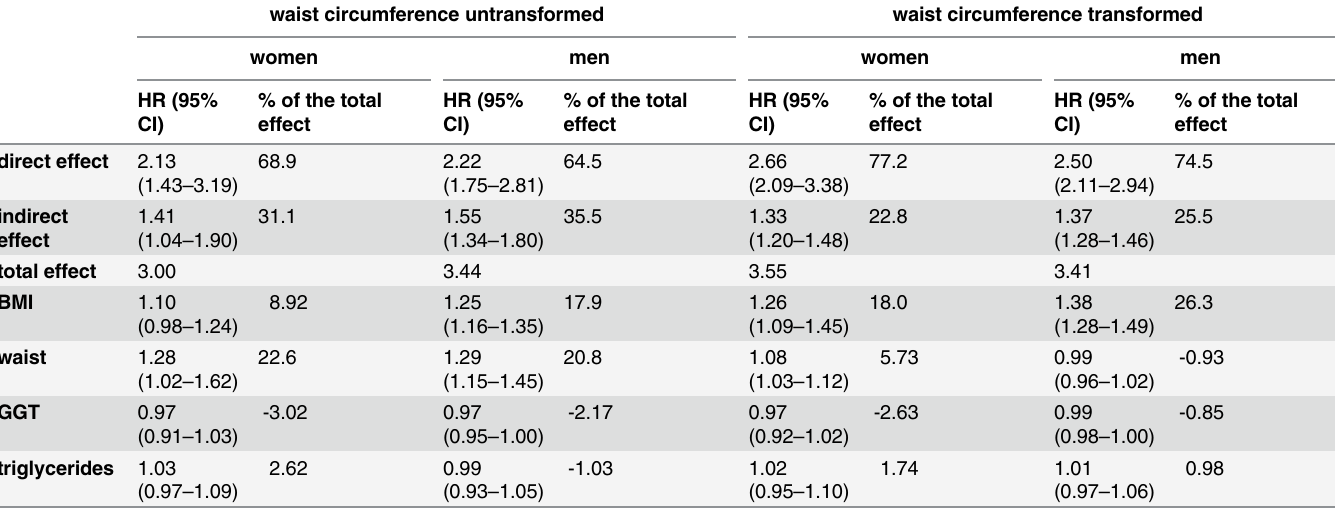
Table 3. Total, direct and indirect effects with 95% CI of the association between the fatty liver index and the risk of type 2 diabetes within EPIC-Potsdam a . waist circumference